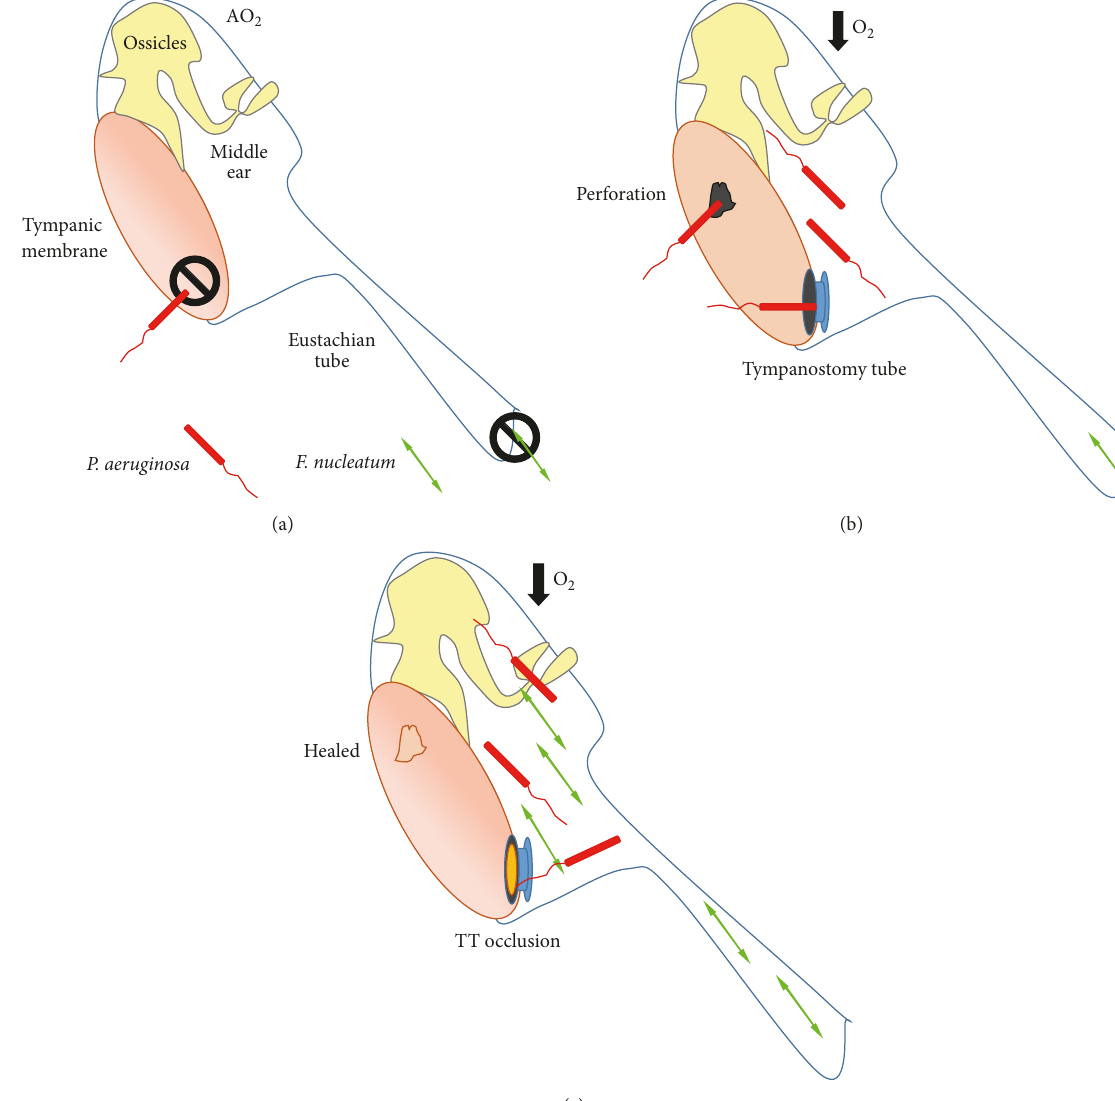
Figure 9: Illustration of the hypothesized mechanism through which the growth of P. aeruginosa within the middle ear supports the growth and biofilm development of F. nucleatum . The details of the proposed mechanism are described within the text. (a) Noninfected, noninflamed middle ear. (b) Chronic suppurative otitis media (perforation) or chronic serous otitis media with effusion treated with myringotomy and TT insertion allow entry of P. aeruginosa , which reduces oxygen with the middle ear. F. nucleatum enters middle ear through the Eustachian tube. (c) Perforation heals or TT becomes occluded trapping the organisms within the middle ear where the two bacterial species live together within the middle ear fluid and coaggregate to form biofilms on the TT or on the mucosal